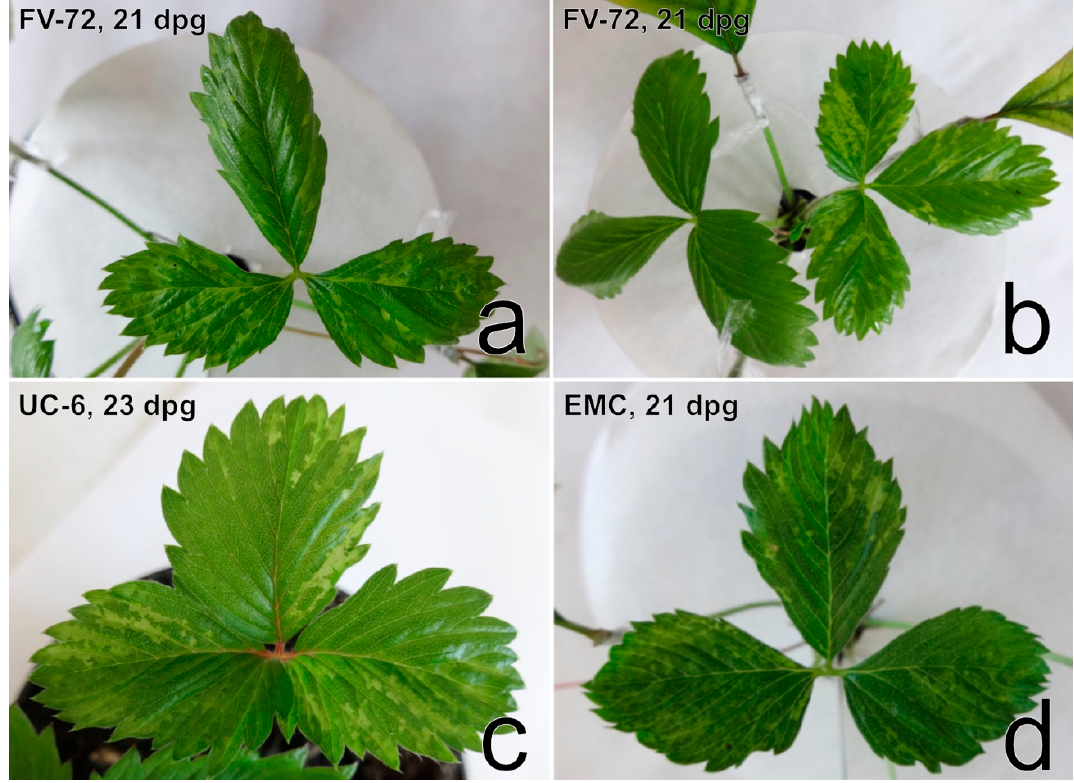
Figure 11. Symptoms of irregular light-green sectors on F. vesca clones after grafting. Dpg—days post- grafting.